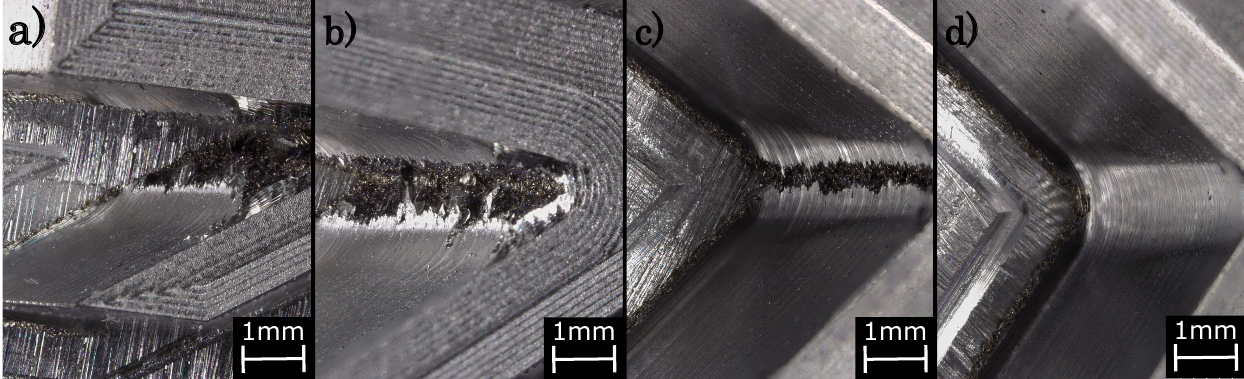
Figure 17. Microscope images of different inner angles with ( a ) 45 ◦ , ( b ) 60 ◦ , ( c ) 75 ◦ and ( d ) 90 ◦ after the milling